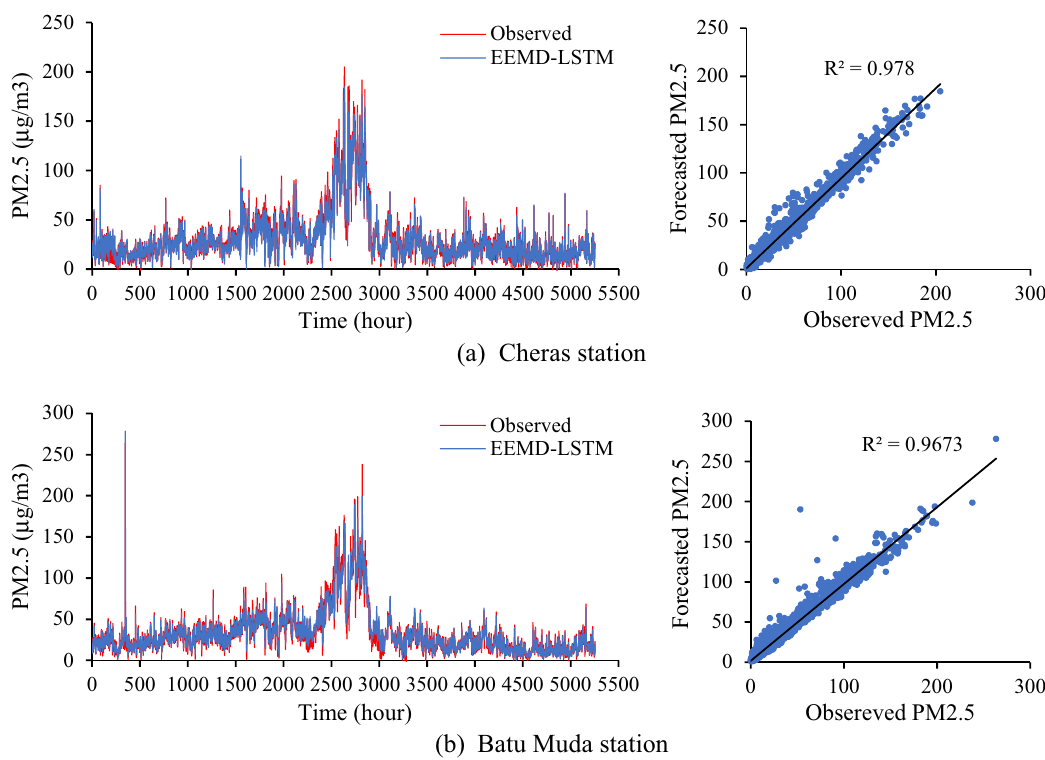
Figure 7. PM2.5 forecasting based on EEMD-LSTM for ( a ) Cheras ( b ) Batu Muda